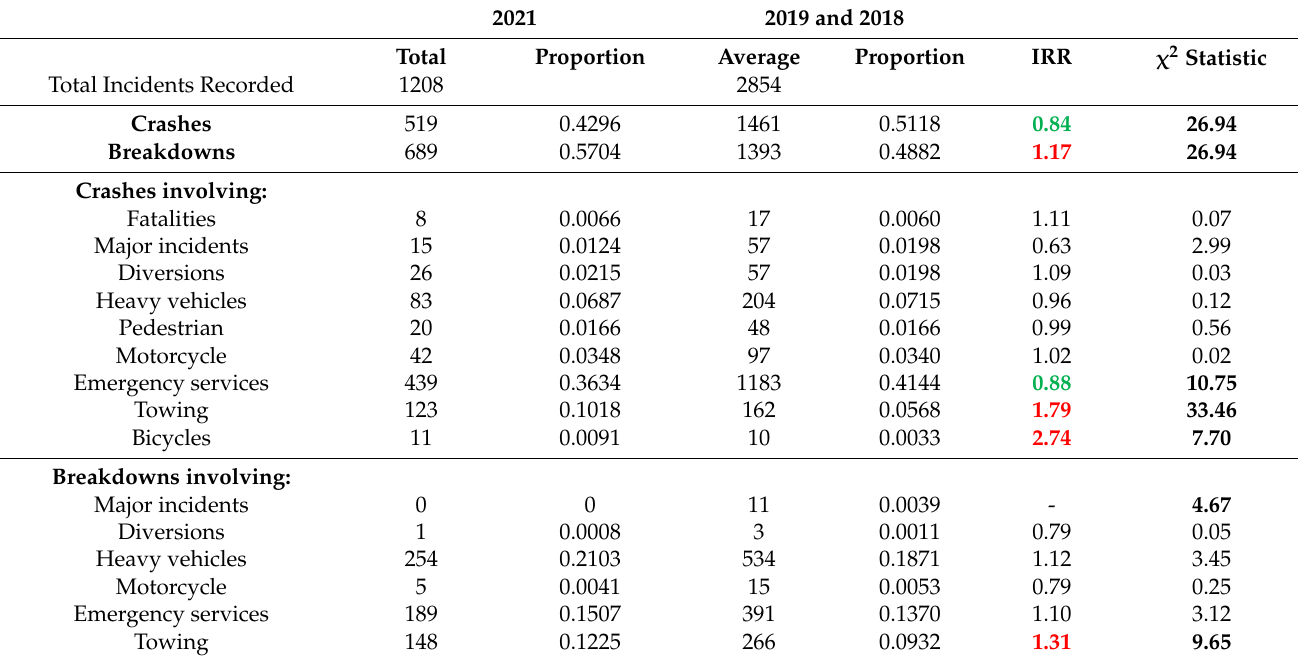
Table 3. Ratio of incident characteristics to the total incidents recorded for the period of 26 June to 31 August in 2021, 2019 and